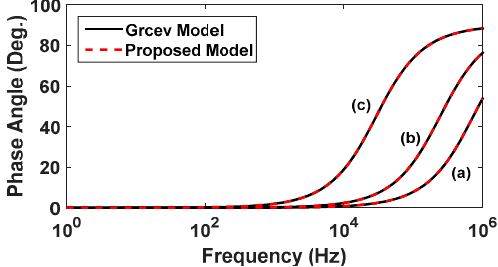
Figure 11. Grounding system effective length. 5.2. A Simple Grounding Grid Figure 12 shows a relatively simple grounding system that consists of several horizontal and vertical electrodes. The evaluation of this grounding system as a second case study is due to the revision of soil capacitive behavior. The Earth capacitive behavior in the theory of the transmission line is fully justified [17]. Figure 12. A Simple Grounding Grid.